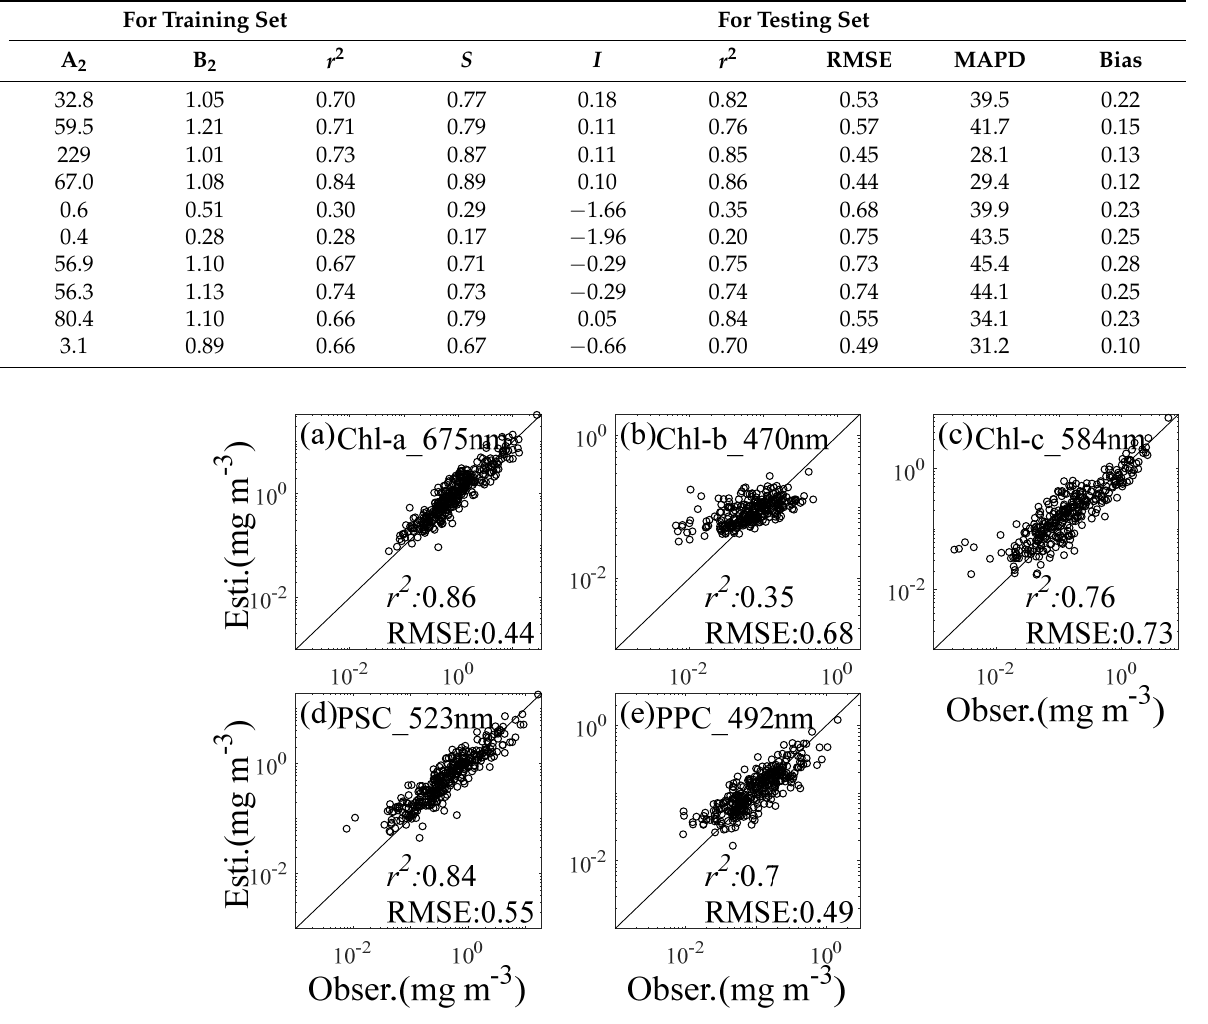
Figure 5. Observed concentrations (Obser.) versus concentrations estimated from the Gaussian model (Esti.) of five main phytoplankton pigment groups ( a – e ) using the testing set. The black line represents the 1:1 line.